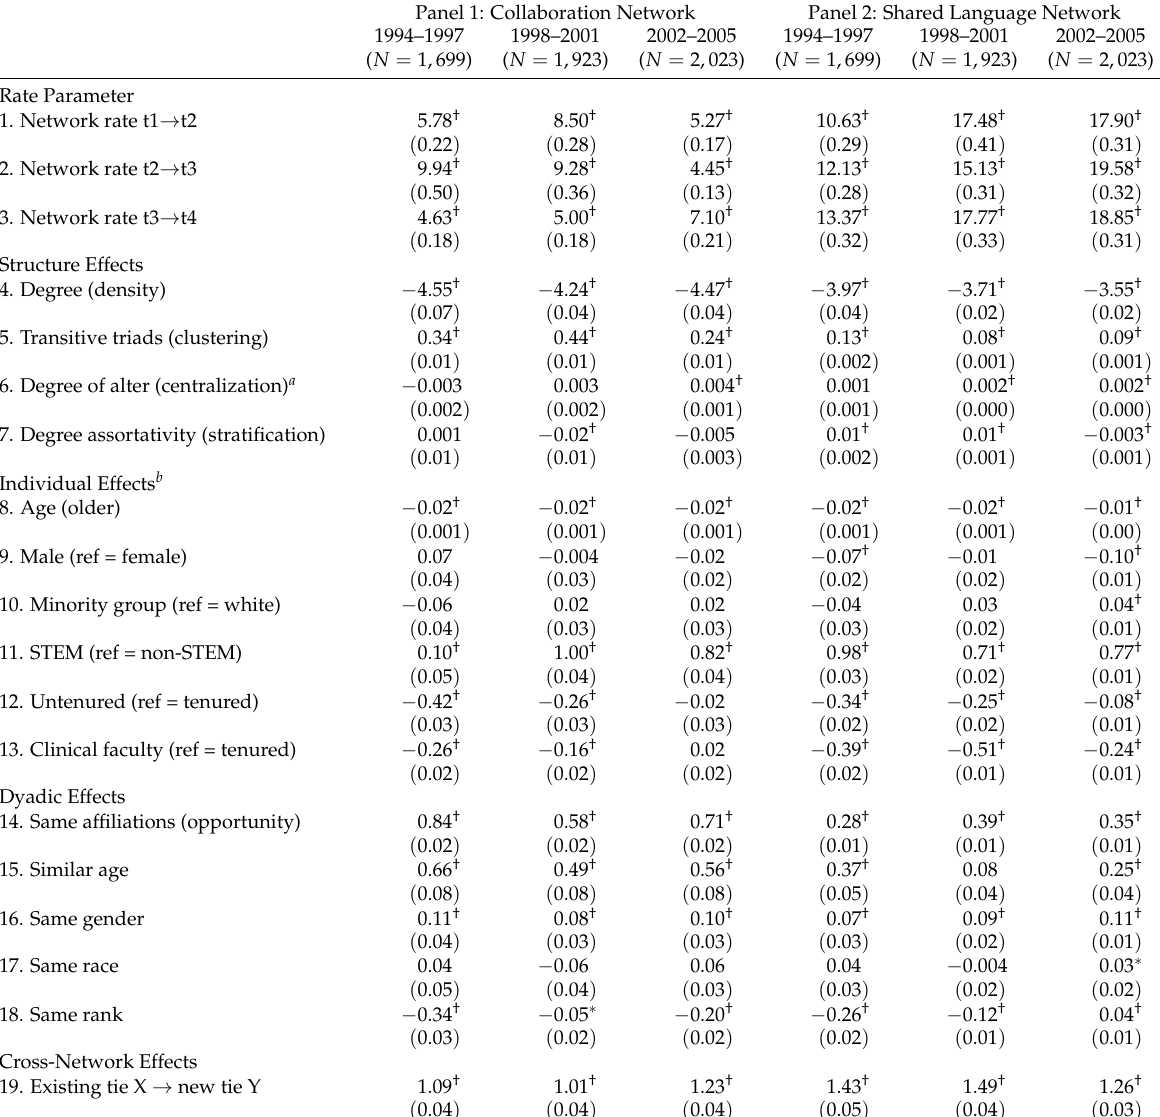
Table 1: Results from dynamic multiplex network models predicting coevolution of collaboration and shared language among faculty members between 1994 and